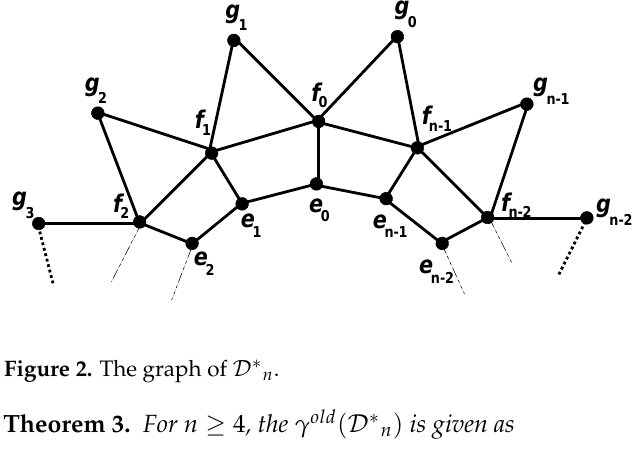
Figure 2. The graph of D ∗ n